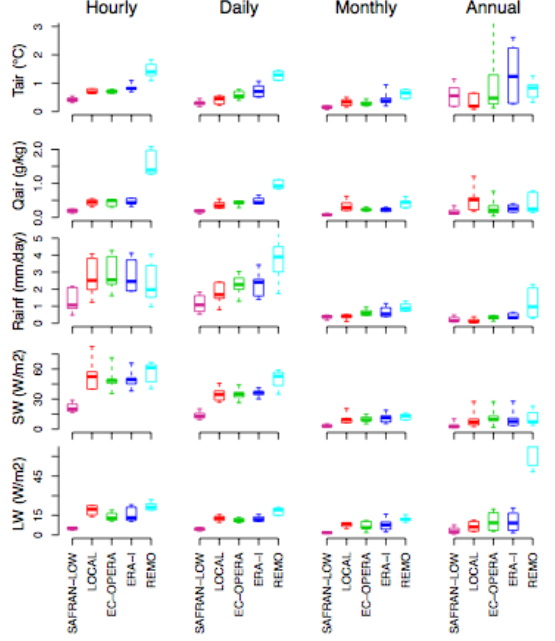
Fig. B3. Mean absolute error (MAE) between meteorological data sets and SAFRAN over 2004 to 2007, except for EC-OPERA which covers only 2004–2006. Time series used to calculate MAE corre- spond to growing season except for at the annual time scale, which covers continuously from 1997 to 2007, whenever data